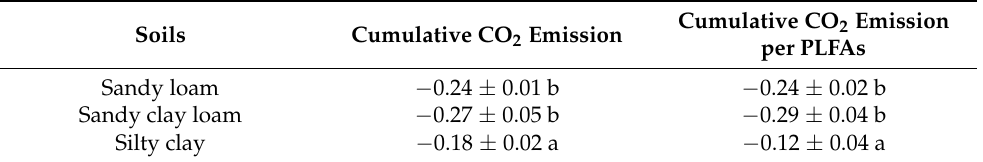
Table 4. Indexes of sensitivity of cumulative CO 2 emissions and microbial metabolic quotient (cumu- lative CO 2 emissions per PLFA) to salinity in the three soils. Different letters indicate statistically significant differences.